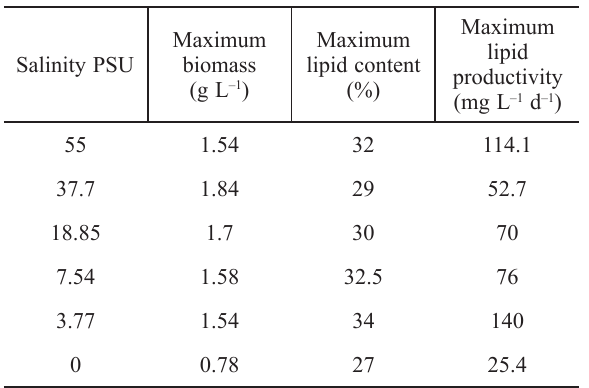
Table 2 – Effect of salinity variation on biomass, lipid con- tent, and lipid productivity